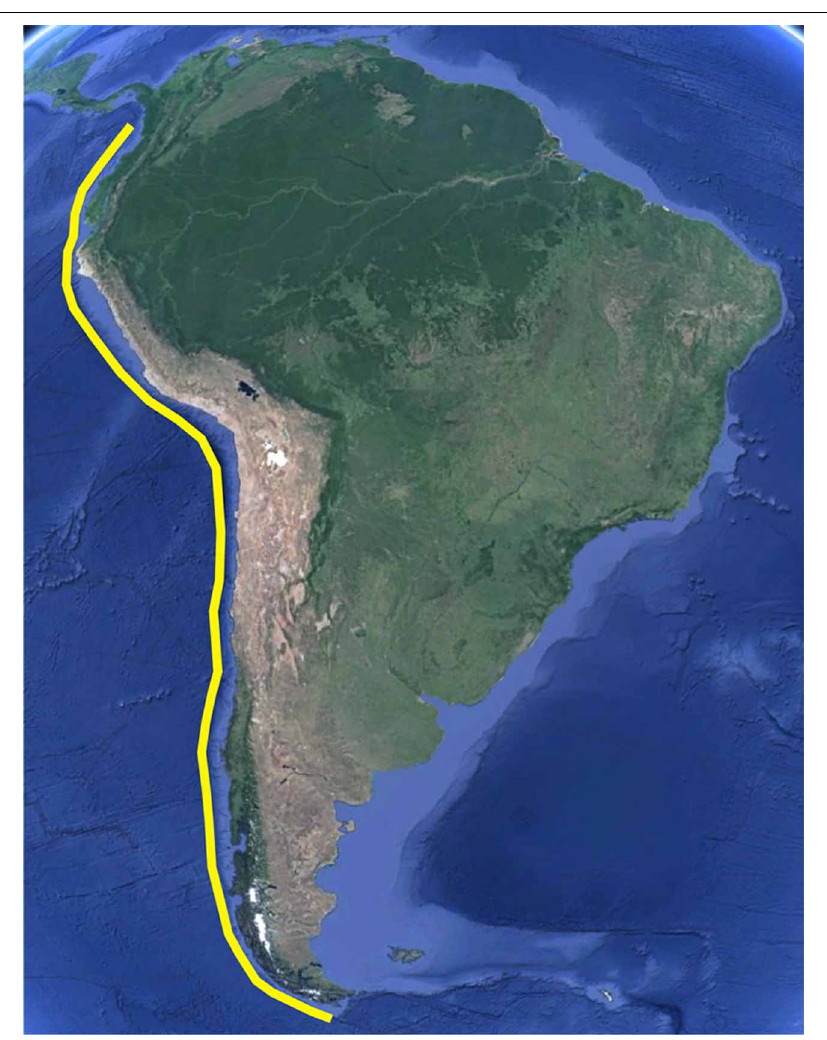
FIGURE 2 | Subduction zones. Subduction zones generally migrate (e.g., through retreat of the trench and rollback of the slab) and change their geometries through time. The South-American subduction zone (trench), indicated here schematically (by a yellow line), is one of the most stable of all the subduction zones (Schellart et al., 2007). While subduction-zone geometries and evolution are well known, we still do not know how subduction zones initiate (Image from Google